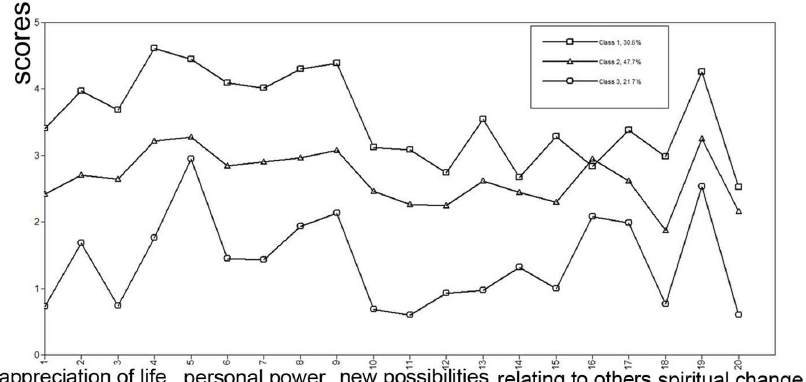
Fig 1. Latent profiles of PTG among OCL people. (A) For analyticalpurposes, we sort the items of C-PTGI by a factor that corresponds to 1–6 for appreciationof life, 7–9 for personal power, 10–13for new possibilities, 14–16 for relatingto others, 17–20 for spiritual